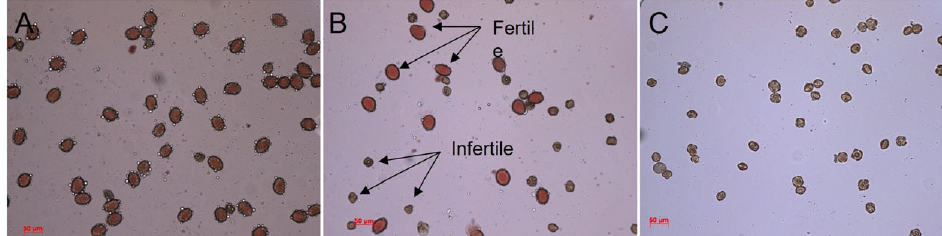
Figure 5. Pollen viability in S 2 generation derived from an allohexaploid Brassica hybrid H16-1 DH population. ( A ) High fertility. ( B ) Medium fertility. ( C ) Low fertility.